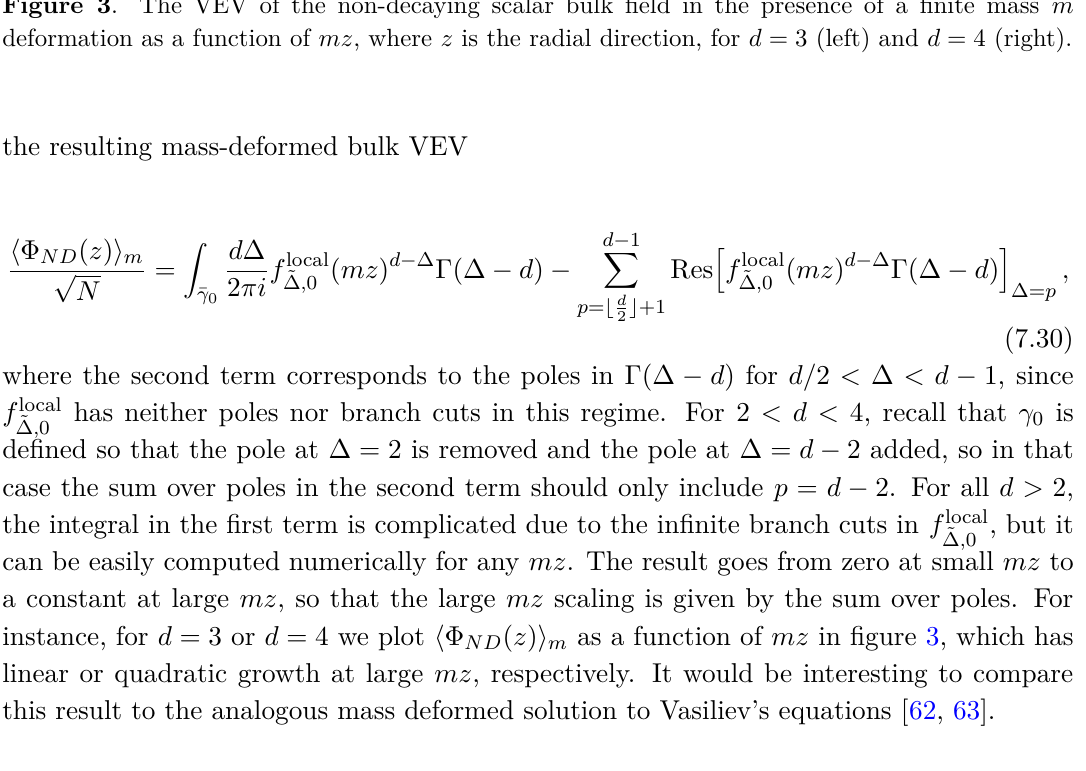
the resulting mass-deformed bulk